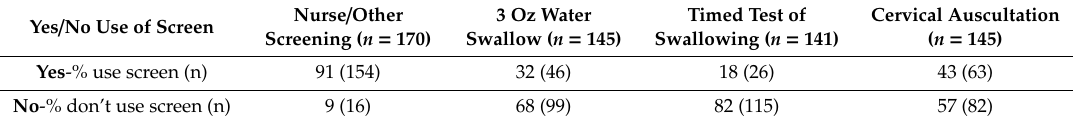
Table 1. Frequency of use for screening assessments and Cervical Auscultation (CA).